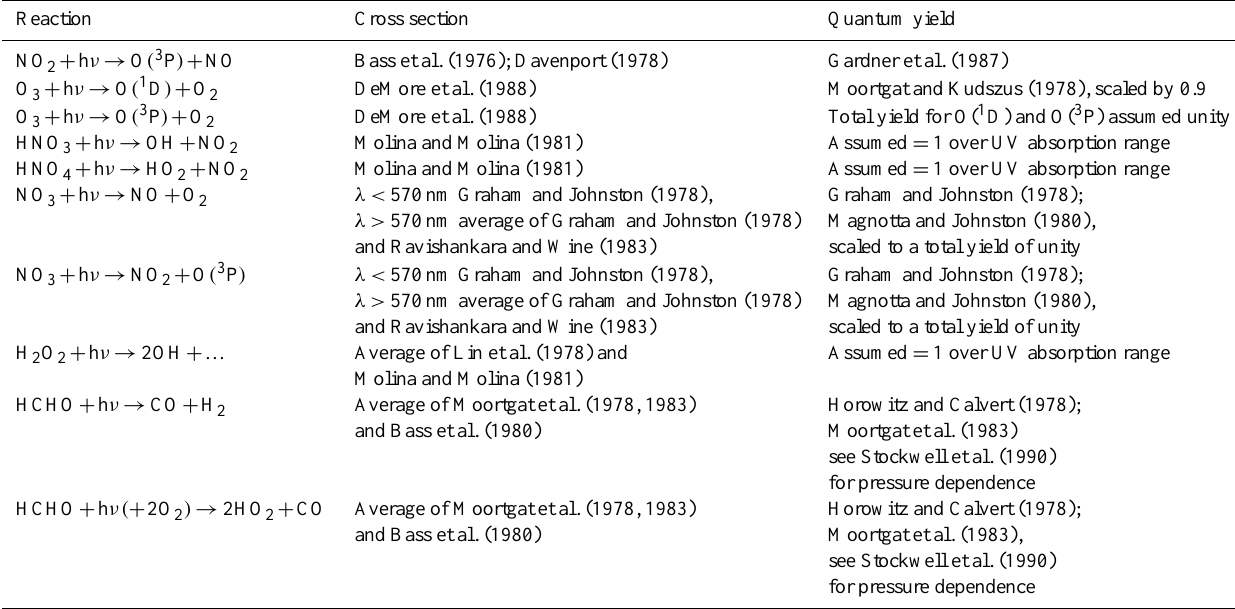
Photodissociation reactions, cross sections, and quantum yields (from the RADM2 chemical mechanism, Stockwell et al., 1990) used in this